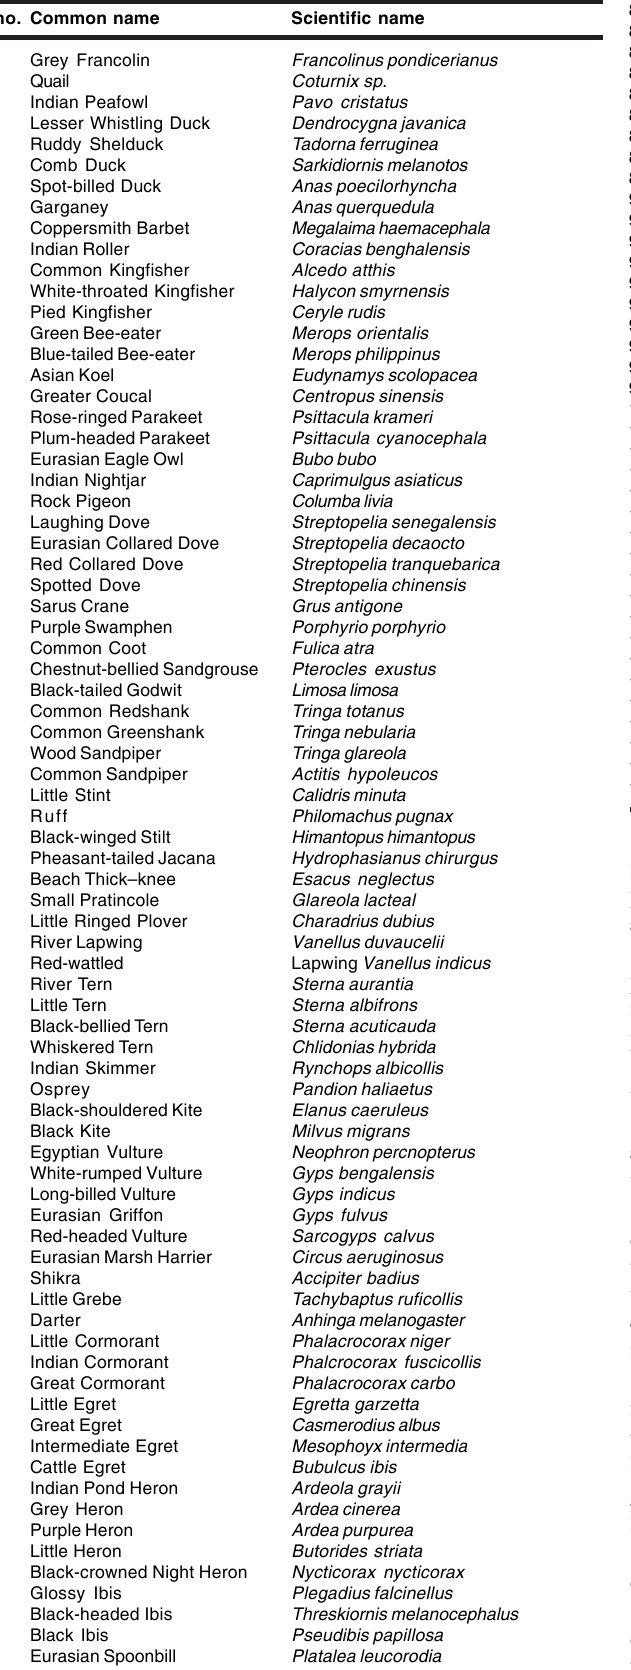
Table 3. Bird species sighted during the Chambal River Expedition in